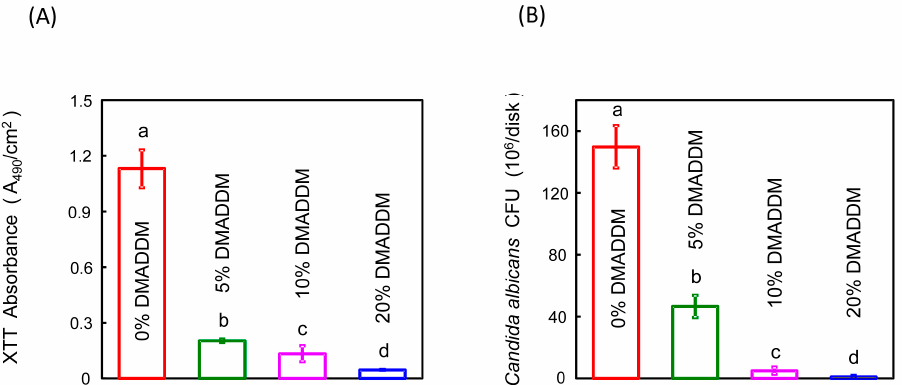
Figure 6. Biofilm metabolic and biomass analysis. ( A ) The XTT results of C. albicans biofilms formed on different DMADDM-containing denture bases. In each plot, dissimilar letters indicate values that are significantly different from each other ( p < 0.05); ( B ) Colony-forming unit counts (CFU) of biofilms. The total CFU counts of 120 h of C. albicans in different dimethylaminododecyl methacrylate (DMADDM)-containing groups. In each plot, dissimilar letters indicate values that are significantly different from each other ( p < 0.05).